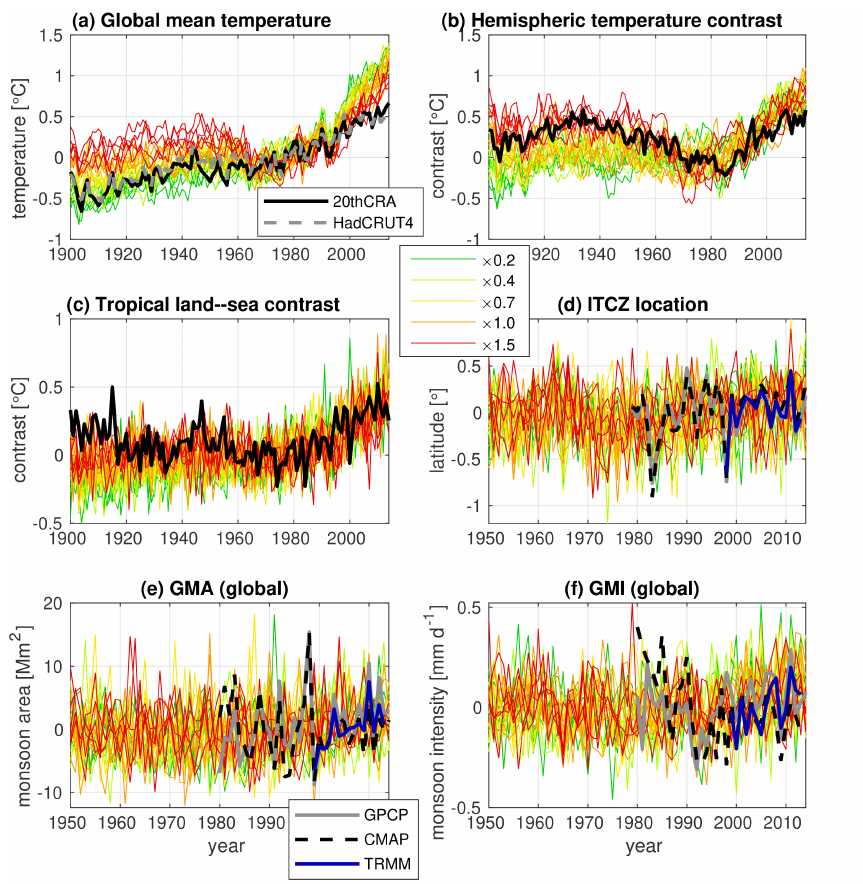
Figure 2. Validation time series comparing the model used in the SMURPHS ensembles (HadGEM3) with observation and reanalysis datasets. For temperature quantities, we use data from 20th Century Reanalysis (20thCRA; Slivinski et al., 2019) and Hadley Centre/Climatic Research Unit Temperature (HadCRUT4; Morice et al., 2012). For rainfall quantities, we use data from the Global Precipitation Climatology Project (GPCP; Adler et al., 2003), the CPC Merged Analysis of Precipitation (CMAP; Xie and Arkin, 1997) and the Tropical Rainfall Measuring Mission (TRMM; Kummerow et al., 2000). All model ensemble members are shown, with no running means. Temperature properties span the period 1900 to 2014; rainfall properties span 1950 to 2014. Sections 3 and 4 of the paper contain descriptions of how the variables are calculated. Anomalies are calculated for each dataset and each experiment, with respect to 1961–1990 (temperature fields) and 1980–2009 (rainfall